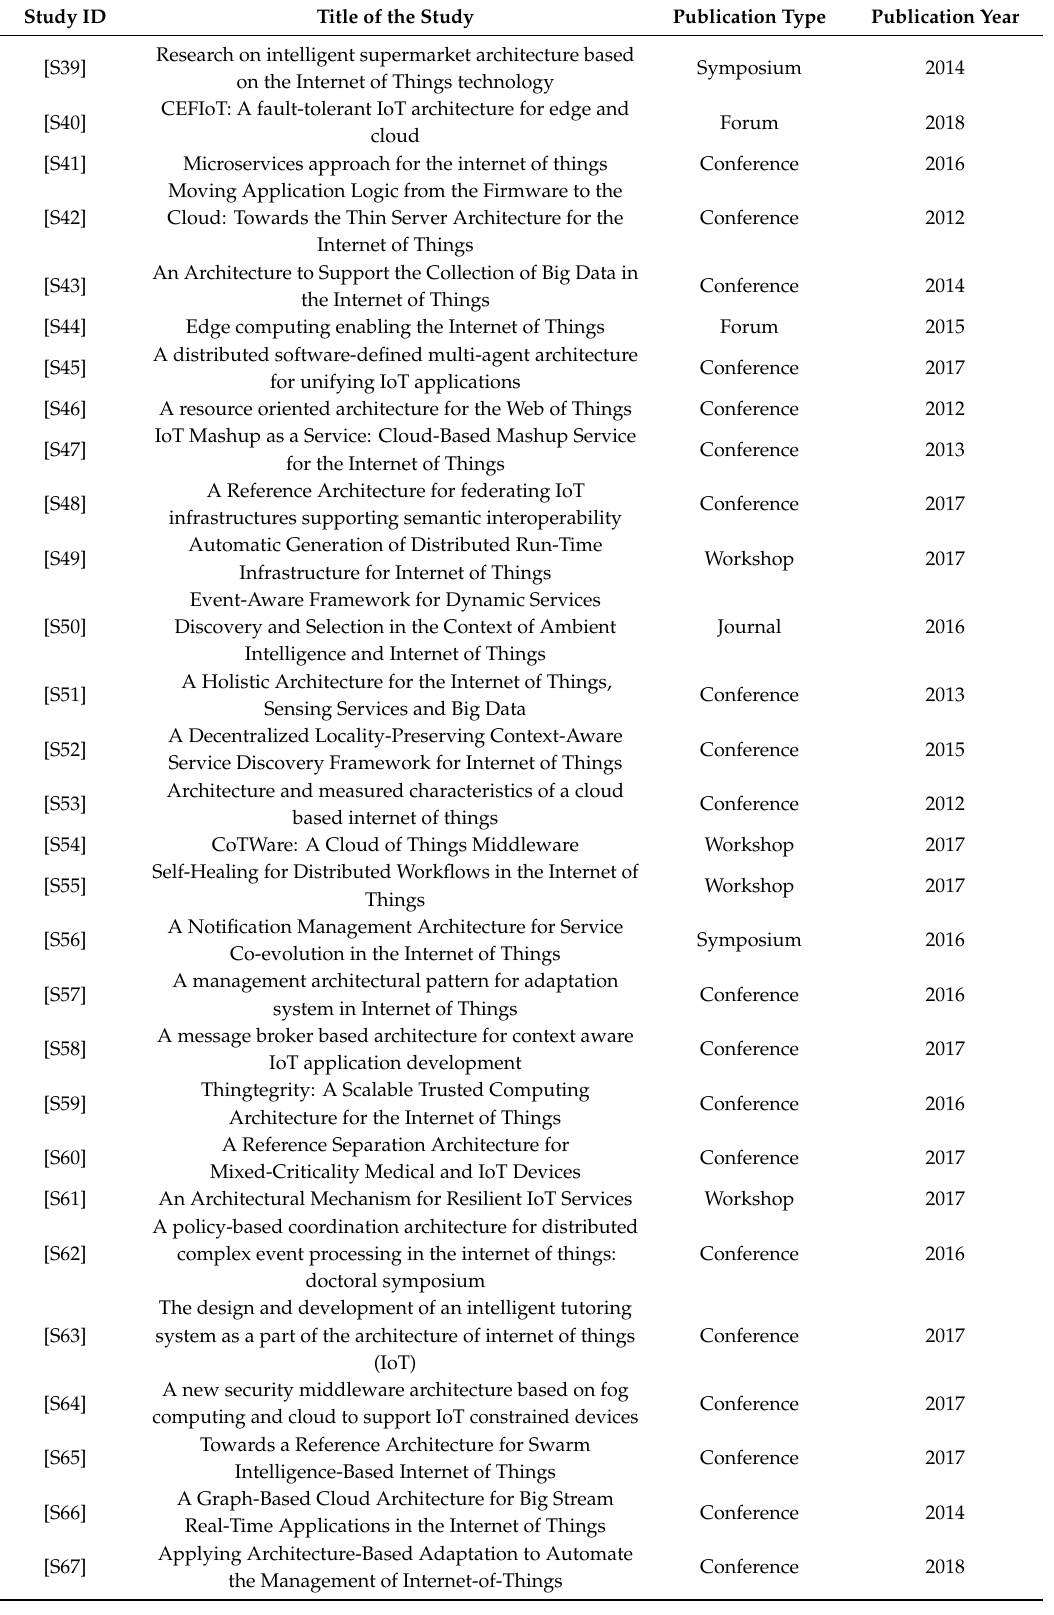
List of Qualitatively Selected Studies (Published Research) for the Systematic Mapping